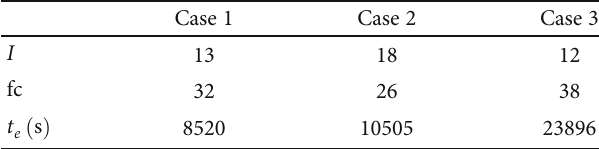
Figure 14: The wing planform views of the baseline UAV and the optimum UAV wings. Table 6: I , f c , and t of Case 1, Case 2, and Case e